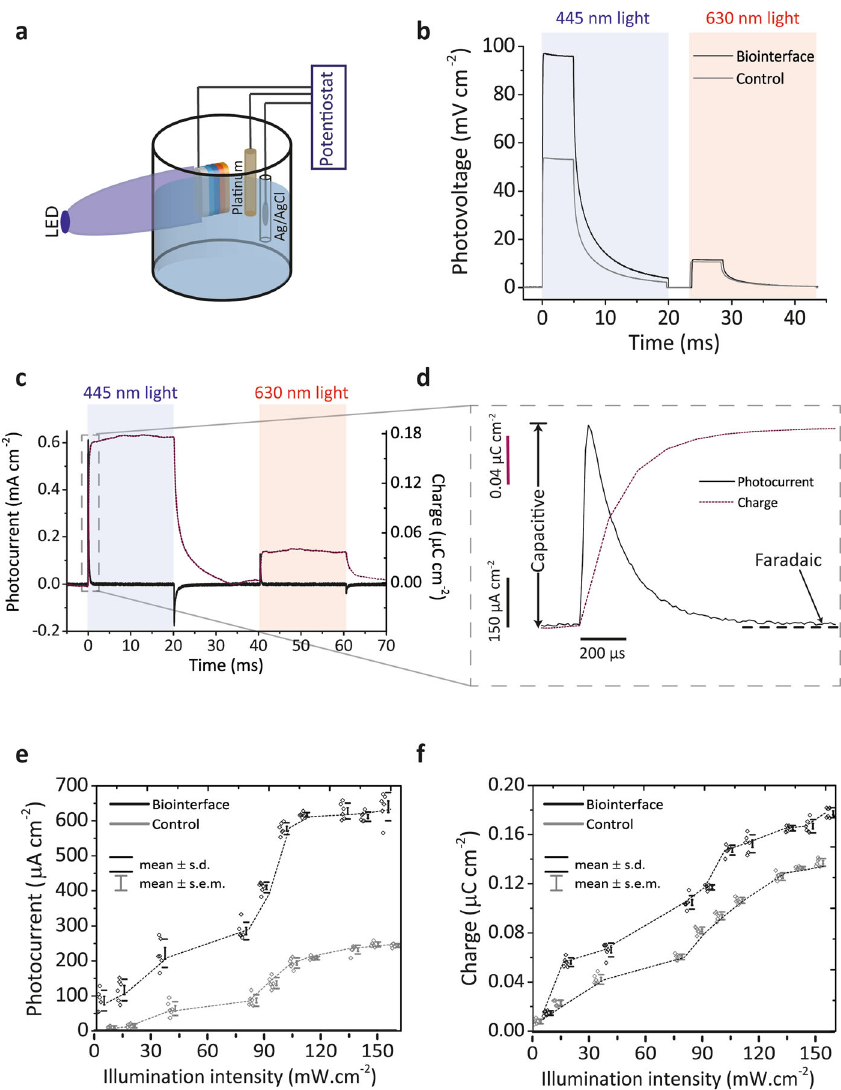
Fig. 2 Optoelectronic responses with AlSb NCs using photoelectrochemical measurements. a Schematic of photoelectrochemical measurement system. A potentiostat module combined with platinum and Ag/AgCl electrodes was utilized for the measurement. The working electrode was directly connected to the ITO layer with a metal clip as the return electrode in the system. The device area of ~1 cm 2 was illuminated and modi fi ed arti fi cial cerebrospinal fl uid was used as the supporting solution. b Photovoltage transient response under the illumination of 445 nm and 630 nm light pulses with trains of 20 ms, 100 mW cm − 2 . Blue and red semi-transparent areas show the 445 nm and 630 nm light illumination periods, respectively. c Photocurrent transient response (black) and charge evolution (purple) under the same conditions as b . The gray dashed box marks the region that is shown in d . d Close-up for the best photocurrent performance under blue light illumination (445 nm) to identify the rise time, capacitive and Faradaic components of the photocurrent response. e Photocurrent and f charge amounts generated by control (gray) and biointerface (black) under different illumination intensities of 20 ms, 445 nm pulses (means ± s.e.m., means ± s.d., n =